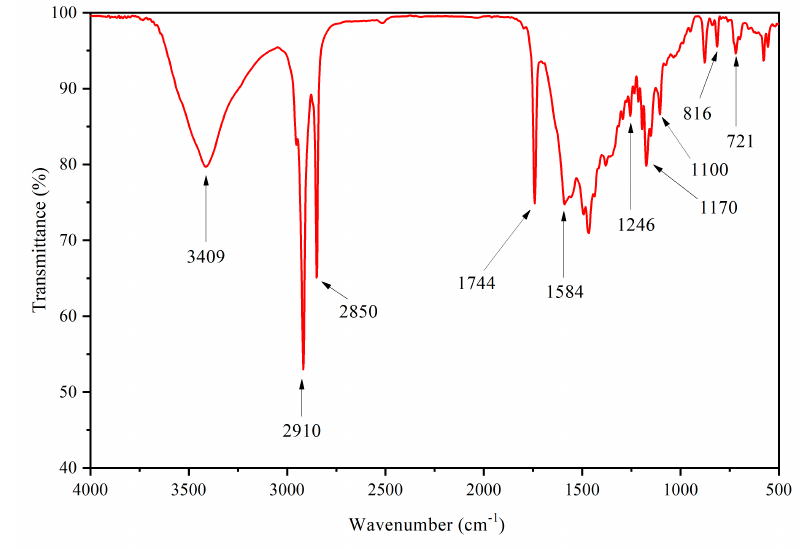
Figure 5. FTIR of thermochromic microcapsules.